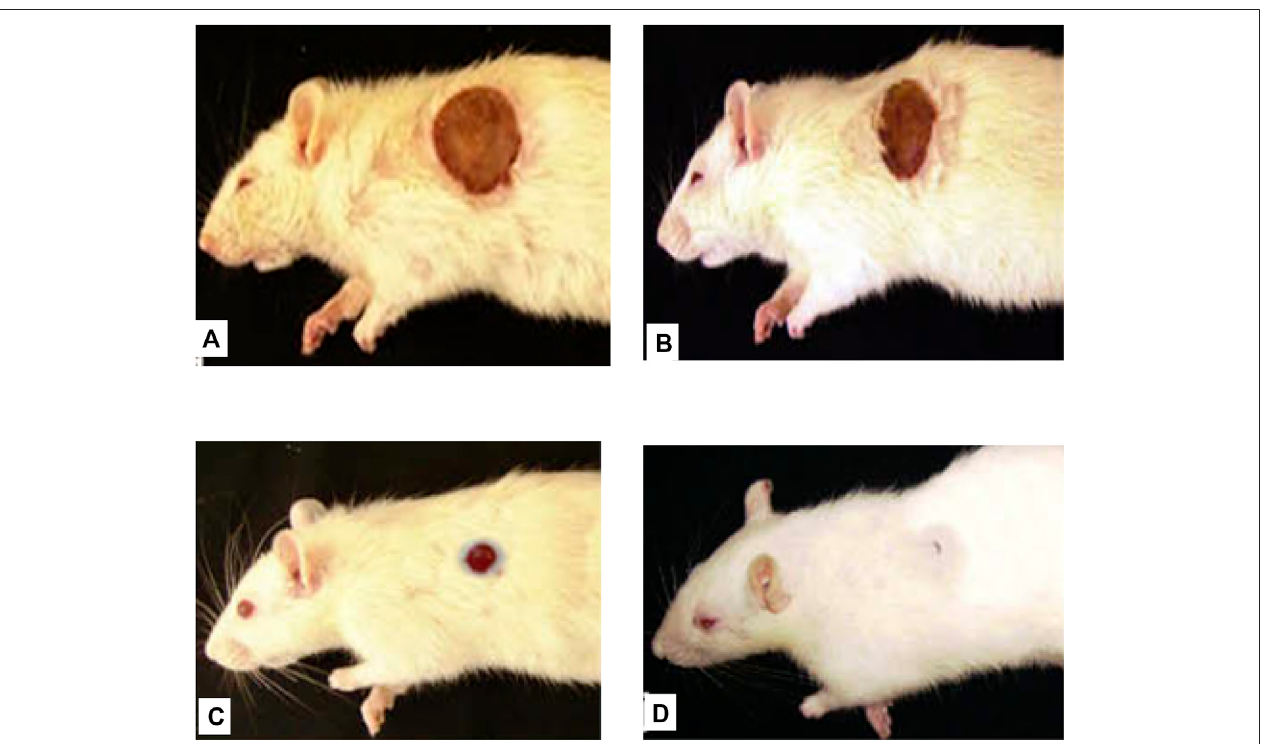
FIGURE7| RepresentativeimageofthewoundhealingprocessinburnwoundmodelatECGHD2%w/wonthe4 th (A) ,8 th (B) ,12 th (C) ,and16 th (D) daysoftreatment.